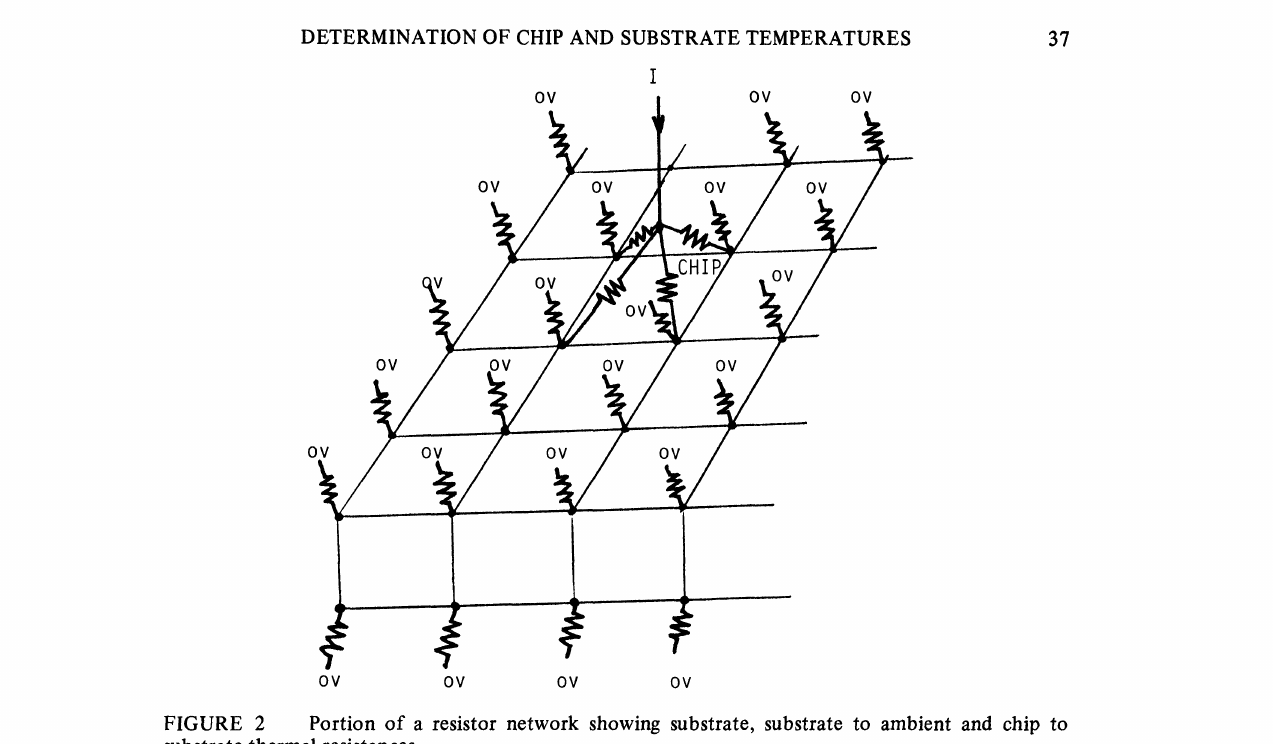
FIGURE 2 Portion of a resistor network showing substrate, substrate to ambient and chip to substrate thermal resistances. substrate can be simulated by a passive resistor network as shown in Figure